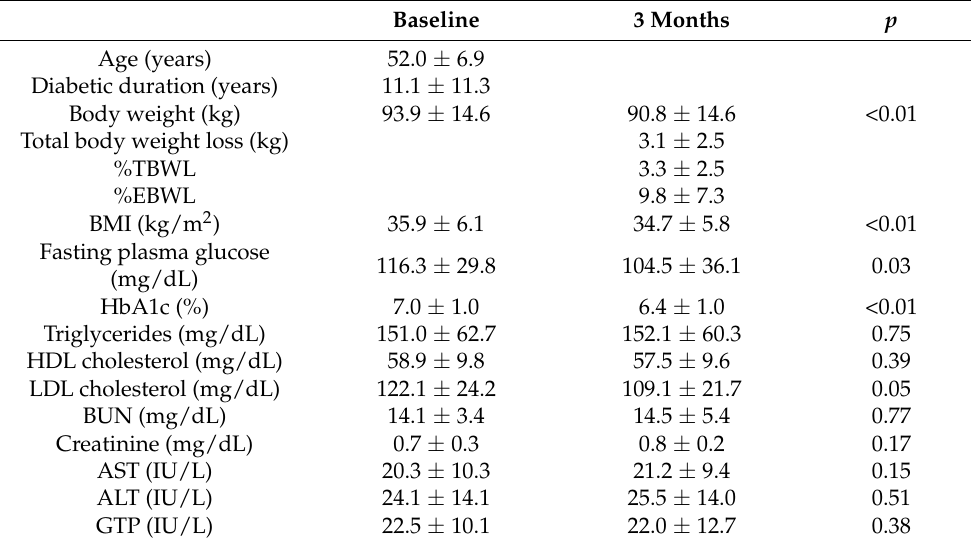
Table 1. Changes in BW and blood metabolic parameters after semaglutide treatment.